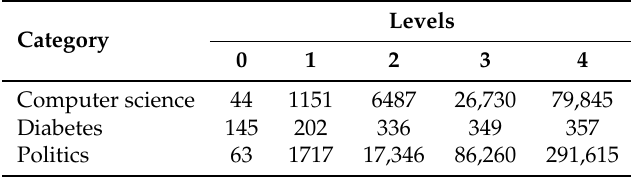
Table 12. The number of Wikipedia pages by category